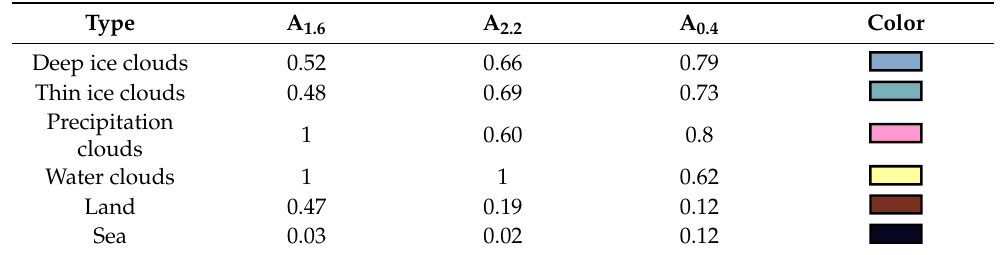
Table 2. Reflectance and RGB colors for different types of clouds, land, and sea (A 1.6 , A 2.2 , and A 0.4 represent the reflectance of 1.6, 2.2, and 0.46 µm after normalization, respectively).